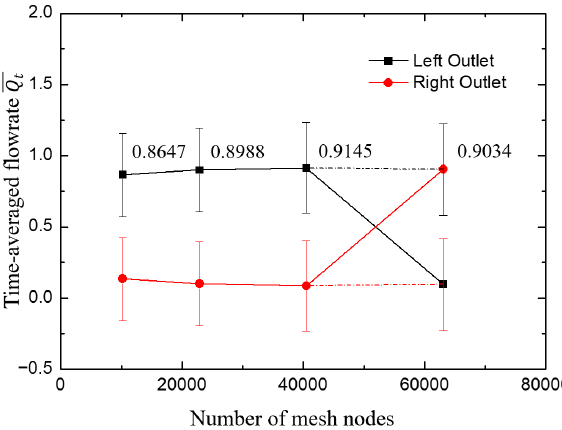
Figure 2. The change of time-averaged flow rate 𝑄 (cid:3047) (cid:3364)(cid:3364)(cid:3364) at outlets with grid number. The error bar is